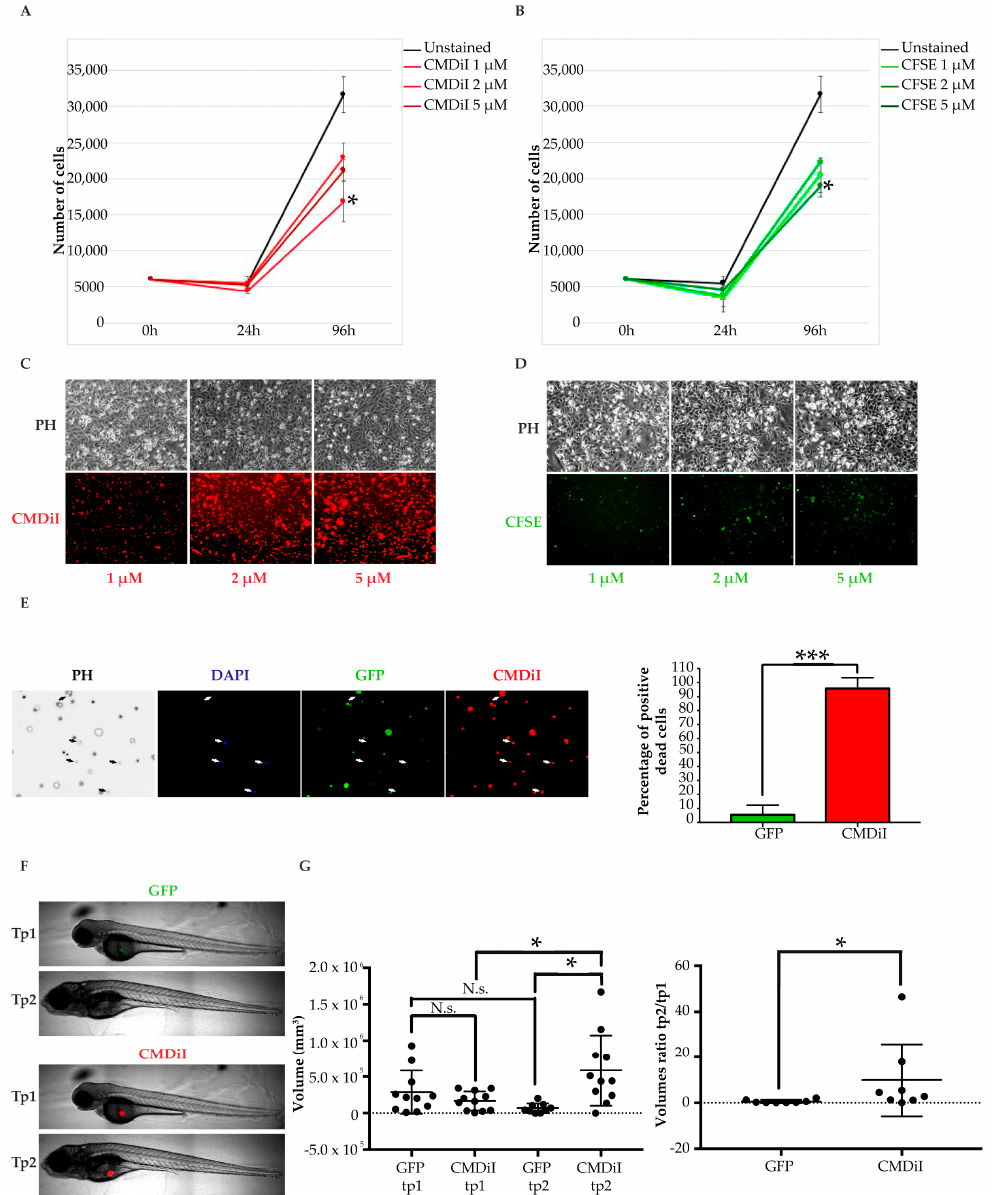
Figure 2. Fluorescent cell labelling methods coparison. ( A,B ) analysis of the toxicity of fluorescent dyes. CMDiI ( A ) and CFSE ( B ) dyes are toxic at different concentrations in MDA-MB-231 (growth curves). Mean and standard deviation of three counts are represented for every condition at each time point; ( C, D ) evaluation of cell staining homogeneity of fluorescent dyes. Representative images of cells stained with CMDiI ( C ) and CFSE ( D ) at day 4; ( E ) assessment of fluorescence retention in dead cells. MDA-MB-231 cells stably expressing GFP were stained with CMDiI and exposed to a high dose of DMSO. Dead cells were detected through DAPI staining. They are indicated by white arrows in the representative pictures on the left and quantified in the graph on the right. Six fields of view were analyzed for quantification. Results are represented as mean +/ − standard deviation; ( F ) representative images of GFP+ and CMDiI+ tumors in the same injected fish at the two time points; ( G ) measurements of tumor volumes corresponding to the same GFP expressing cells and CMDiI labelled cells transplanted in each larva, at tp1 and tp2 (graph on the left). GFP+ and CMDiI+ tumor masses ratios between tp2 and tp1 (graph on the right). Each dot in the graphs represents the measurement of a fish. * indicates p < 0.05, ** means p < 0.01, 3 *** signify p < 0.001, and **** stays for p < 0.0001. No statistical significance is indicated by ns.